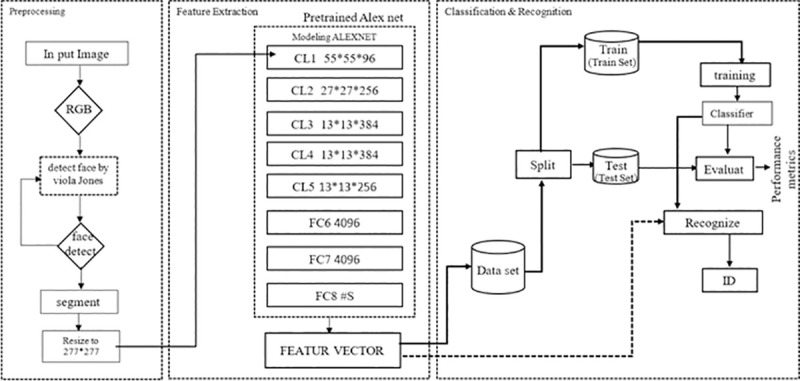
The general overall view of the proposed face recognition system.